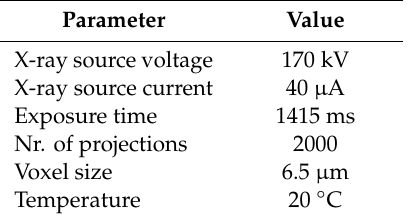
Table 3. CT-scanning parameters used for investigating the bone